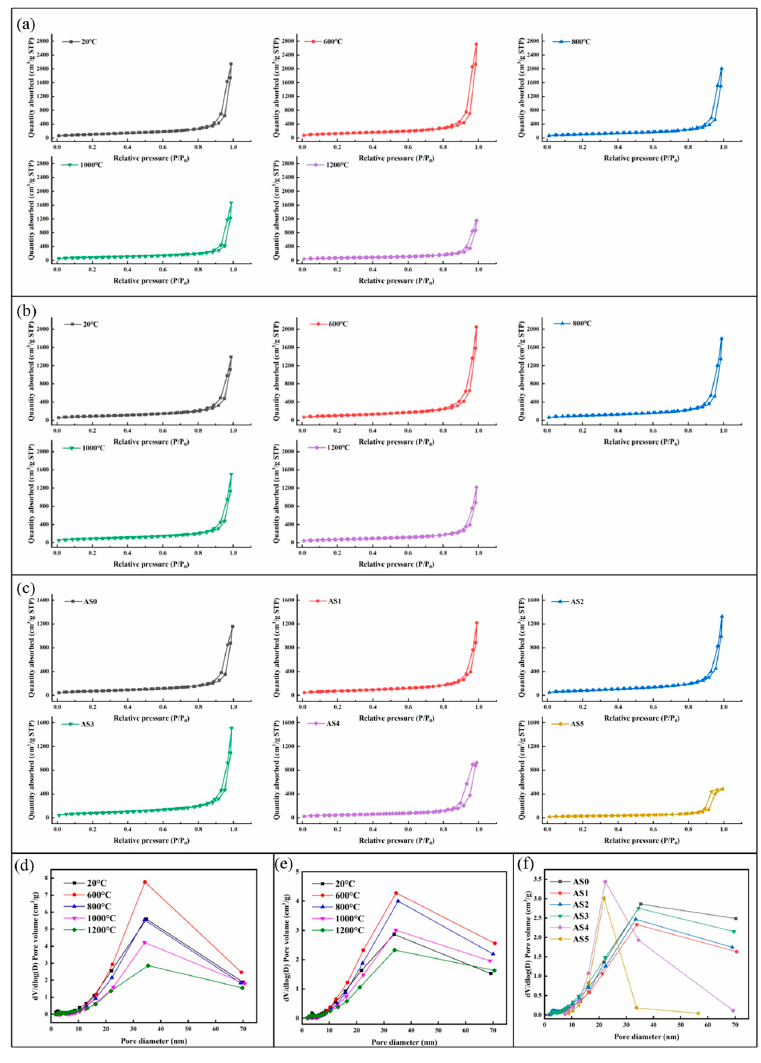
Figure 7. N 2 adsorption–desorption isotherms of ( a ) AS0, ( b ) AS1 and ( c ) all AS samples after heat treatment at 1200 °C; pore size distribution of ( d ) AS0, ( e ) AS1 and ( f ) all AS samples after heat treatment at 1200 °C.